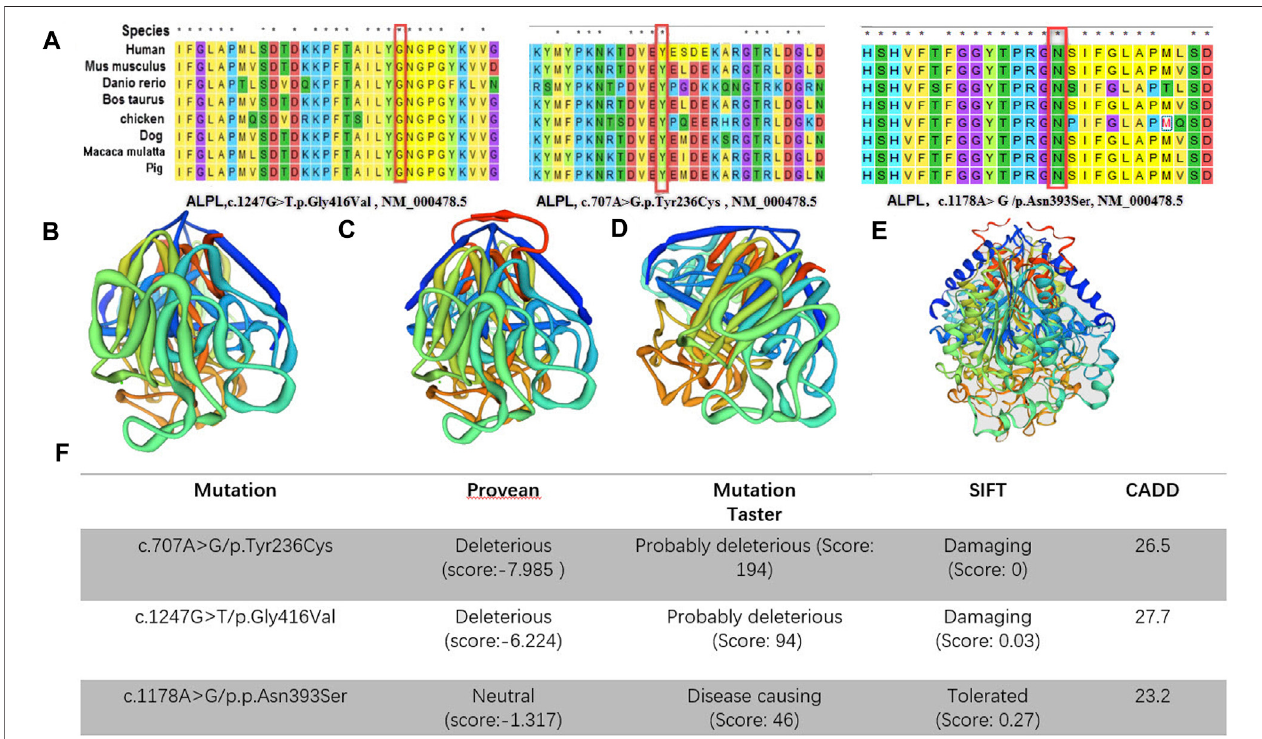
FIGURE 3| (A) , Conservative analysis of the variations; (B – E) Three-dimensional structuresof alkaline phosphatase[ (B) : wild-type, (C) : c.1247G > T/p.Gly416Val mutant-type, (D) :c.707A > G/p.Tyr236Cysmutant-type,c.1178A > G/p.Asn393Sermutant-type]; (F) , in silico predictions.Theimpact ofbothofthe ALPL variants was predicted using fi ve in silico